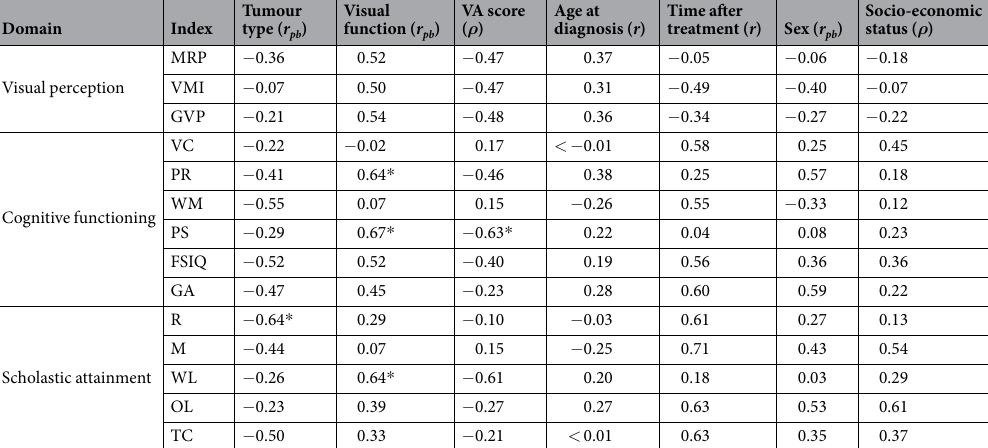
Table 3. Correlations (point-biserial coefficient rpb, Spearman’s ρ , Pearson’s r) across the neuropsychological indices of visual perception, cognitive function and scholastic attainment in relation to clinical and socio- demographic factors. Note: tumour type (1: sporadic, 2: syndromic), visual function (1: poor, requiring visual aids, 2: good, not requiring visual aids) and sex (1: female, 2: male). VA = visual acuity; MRP =